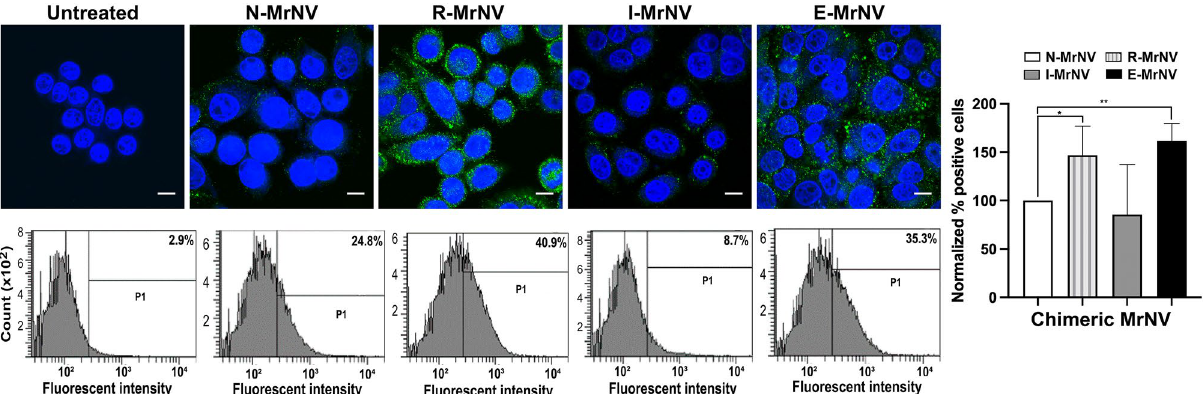
Figure 3. Binding of chimeric MrNV-VLPs to SW480 colorectal cancer cells. SW480 cells were incubated with all types of chimeric MrNV-VLPs and were stained with anti-MrNV and the corresponding secondary antibody conjugated with Alexa 488 (green) and either viewed by confocal microscopy (upper rows, bars = 10 μm) or analyzed by FACSCanto flow cytometer and FACSDiva software version 4.1.1 (https:// bd- facsd iva. softw are) (lower rows). The percent MrNV positive cells and their statistical analysis were shown in the right-most panels (mean ± SEM, n = 3, * p < 0.05, Student’s t